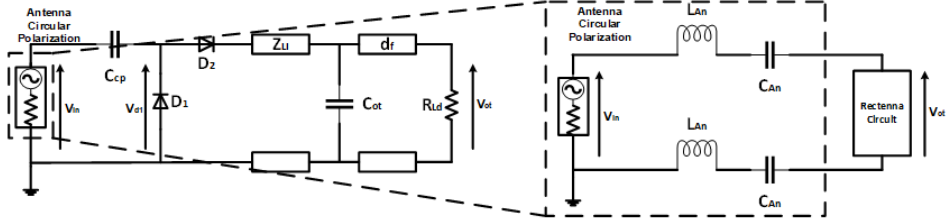
Figure 8. Equivalent Circuit of the CP antenna Energy Source.